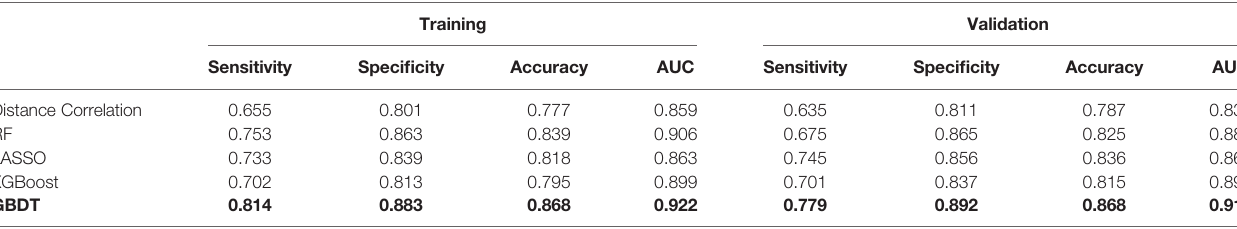
TABLE 2 | The performance of fi ve different models.